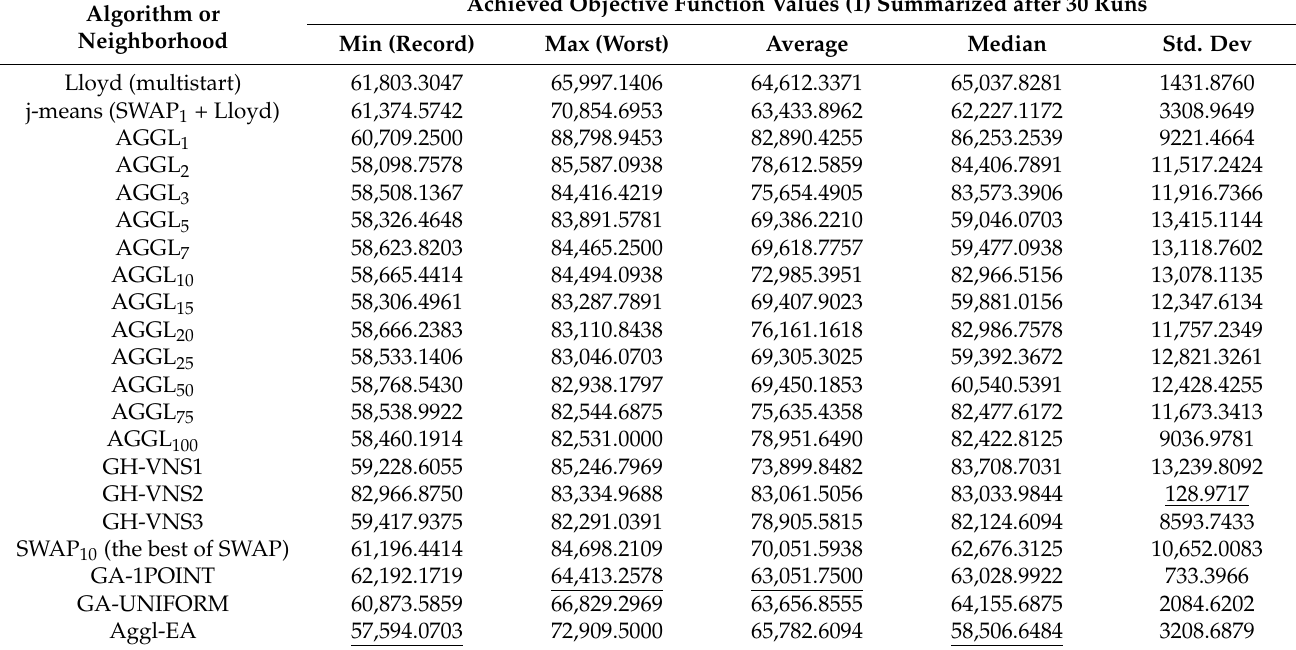
Table A13. Comparative results for Individual Household Electric Power Consumption (IHEPC) dataset. 2,075,259 data vectors in R 7 , p = 100 centers, time limitation 5 min.